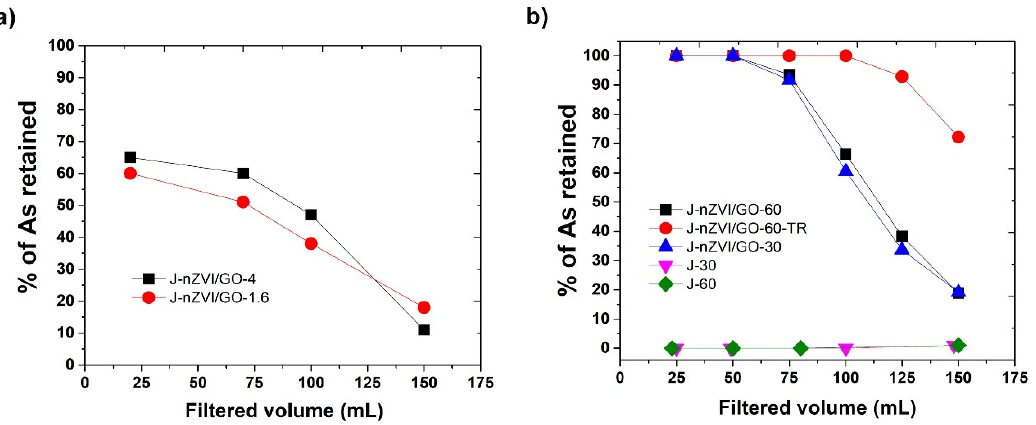
Figure 7. ( a ) Arsenic retention percentage using 1.6 and 4 g of fibers with nZVI/GO, ( b ) arsenic retention percentage in natural fiber and activated fiber in a column with 30 and 60 cm (labels: J-30, J-60, J-nZVI/GO-30, and J-nZVI/GO-60) and a time retention of 20 min (label: J-nZVI/GO-60-TR).